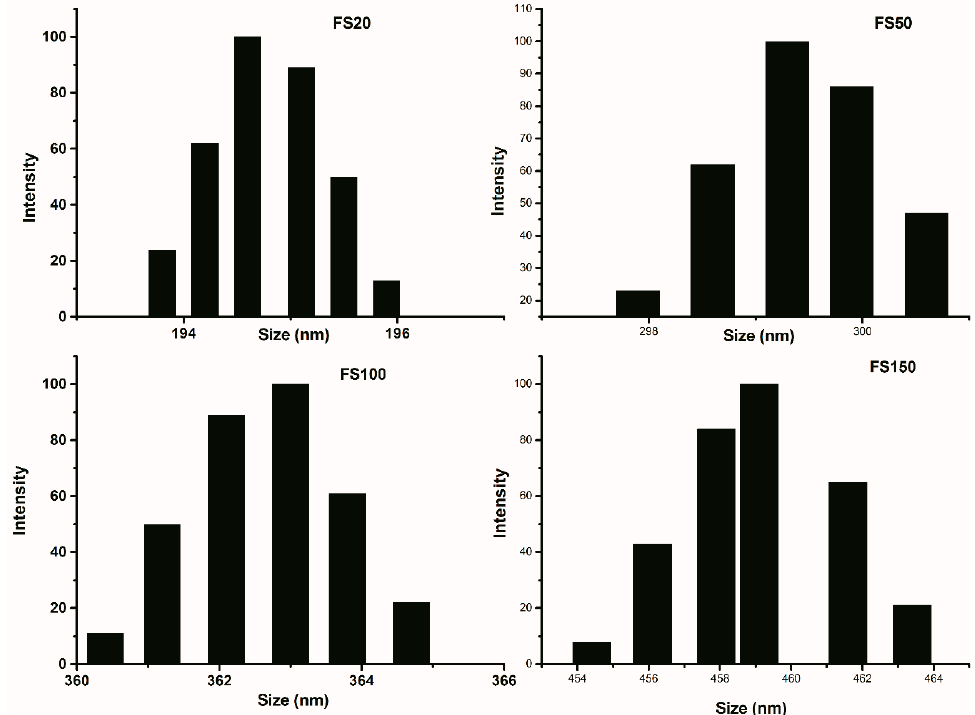
Figure 4. The size distribution of agglomerates for soot collected from different flame heights: FS20, FS50, FS100 and FS150. (Measured by particle size analyzer.).